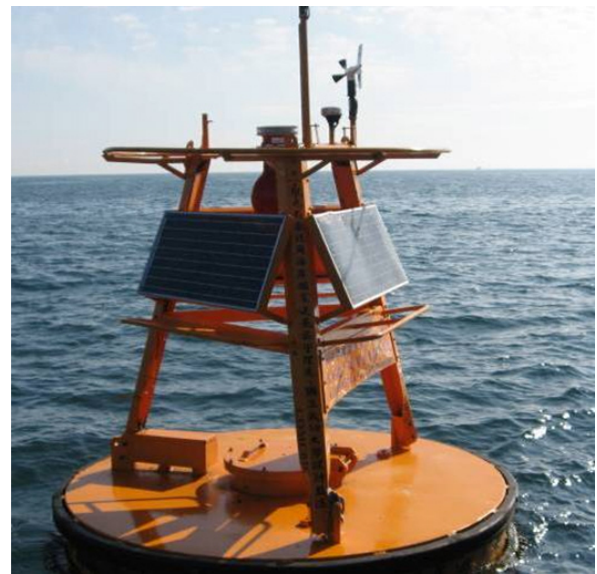
Figure 4. A deployed CWB Buoy. Fig. 4. A deployed CWB buoy.